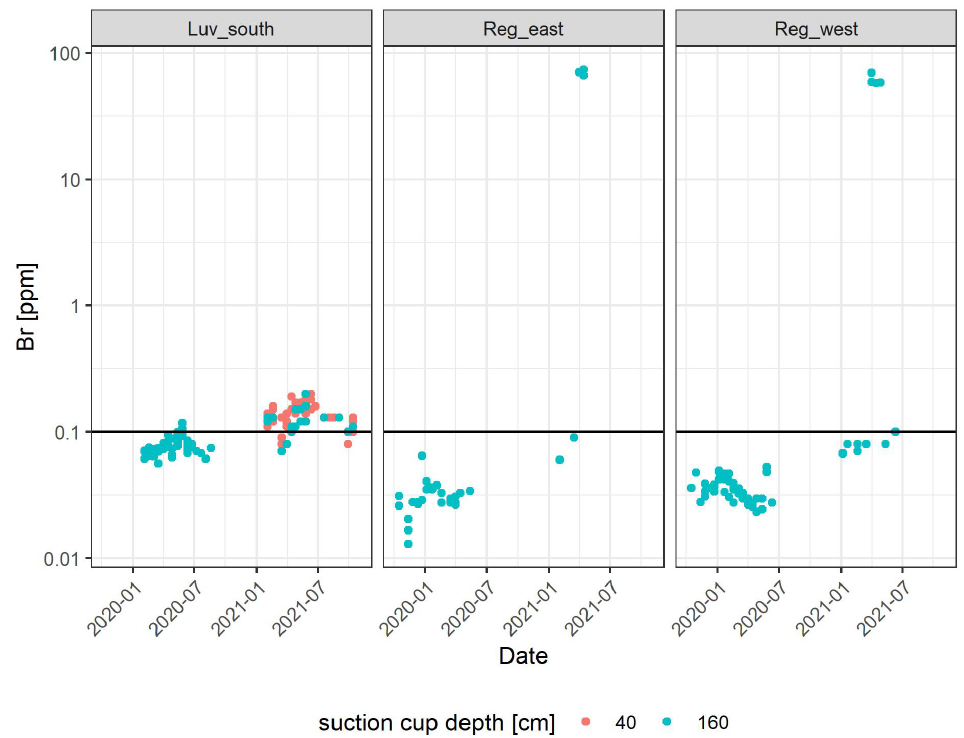
Figure 5. Bromide concentrations in ppm were measured in the suction cup profiles 3 m downhill from the tracer application trench. The horizontal black line indicates the background value of the two profiles measured in the period from 2010 to 2013. The detection limit is 0.05 ppm. Note that the detection limit for Bromide in the suction cup sampling is smaller than in the measurements with the ion-sensitive electrode.